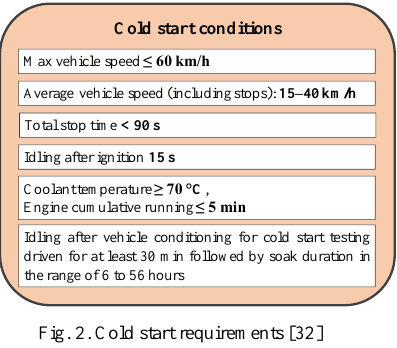
Fig. 2. Cold start requirements [32]